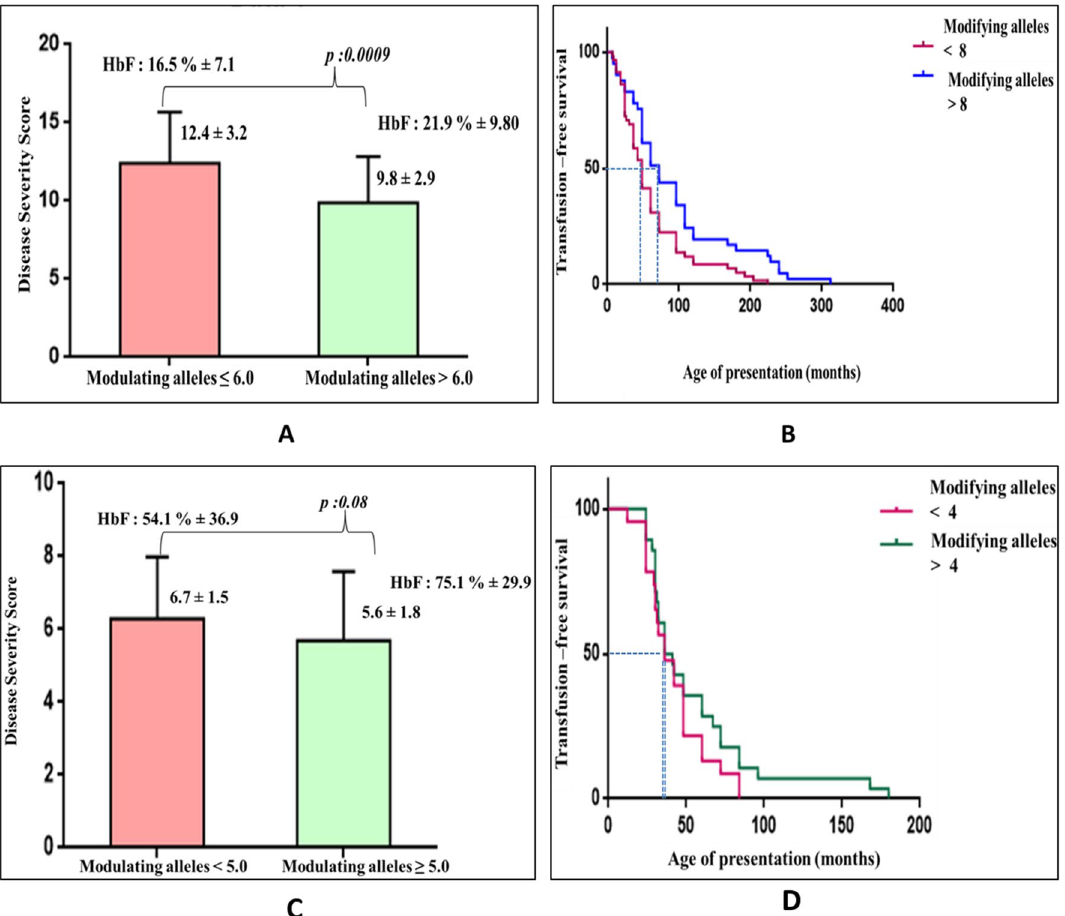
Figure 4. Association of disease ameliorating alleles with disease severity in the patients. ( A ) Depicts the disease severity score against the median number of HbF modulating alleles in the SCA patients. The patients with higher number of modulating alleles showed significant positive correlation with the HbF levels (mean HbF: 21.9% ± 9.8) as compared to the other patient group. ( B ) Kaplan Meier transfusion free survival curve was plotted considering all the genetic modifiers (α-thalassemia and the HbF modifiers) and a delayed median age of presentation in patients with more number of modifying alleles: 72 months was observed as compared to the other group: 48 months (P: 0.02, Gehan Breslow Wilcoxon test). ( C ) Depicts the disease severity score (DSS) against the number of HbF modulating alleles in the β-thalassemia intermedia patients. The patients inheriting more number of the disease ameliorating alleles showed elevated HbF levels (mean HbF: 75.1% ± 29.9), with reduced disease severity score (mean DSS: 5.6) as compared to the patients in the other group (P: 0.08). ( D ) Kaplan–Meier transfusion free survival curve analysis (considering both primary and secondary modifiers) showing slight delay in median age of presentation in patients with more number of modifying alleles (38.5 months) as compared to group (36.0 months) (P: 0.36, Gehan Breslow Wilcoxon